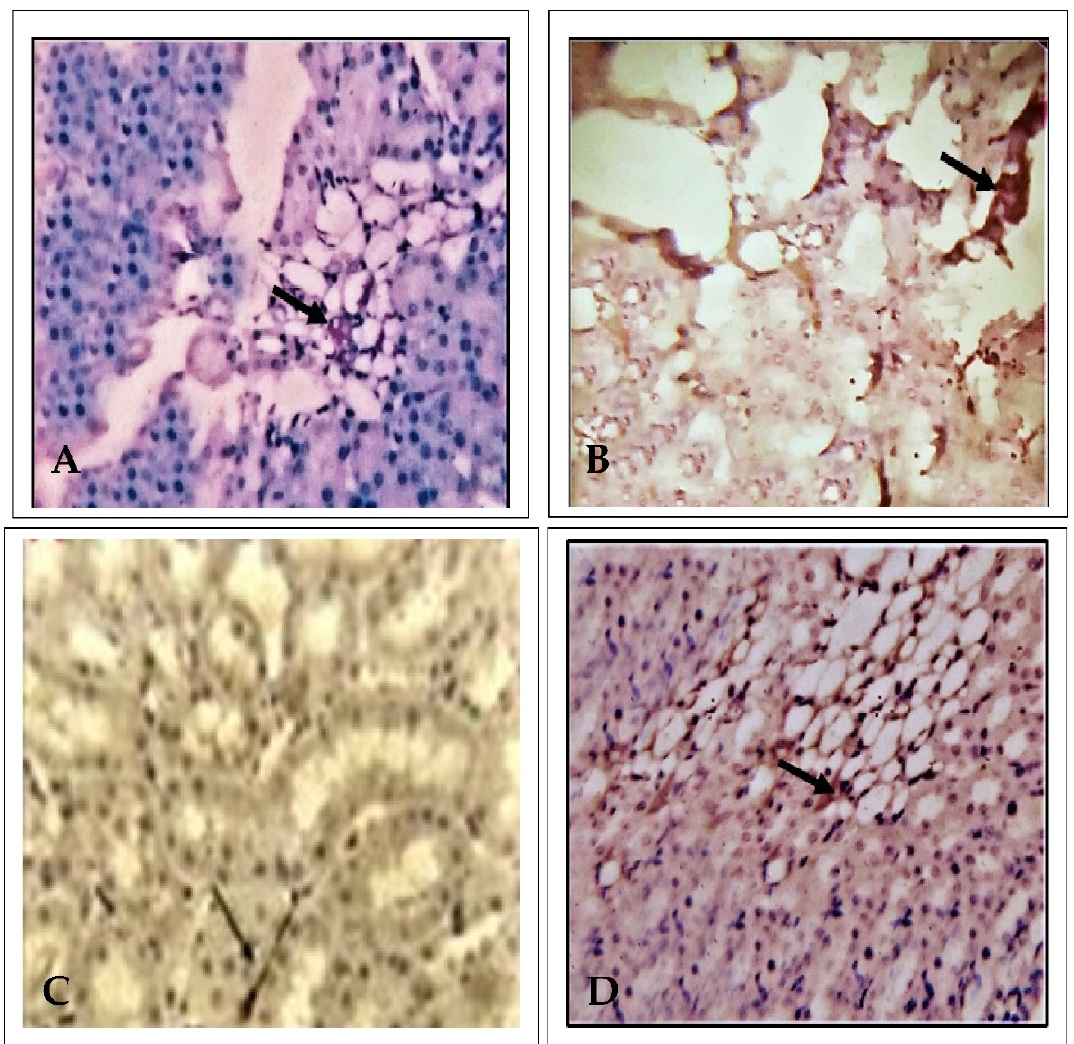
Figure 5. Alpha glutathione S-transferase ( α -GST) immunohistochemistry of the kidney (200× magnification). ( A ) Control, ( B ) lead acetate (PbA; 30 mg/kg body weight (b.w.)), ( C ) N -acetylcysteine (NAC; 200 mg/kg b.w.) + PbA (30 mg/kg b.w.), and ( D ) ethanolic extract of Celastrus paniculatus seeds (EECP; 800 mg/kg b.w.) + PbA (30 mg/kg b.w.). The arrows indicate immunopositive regions.